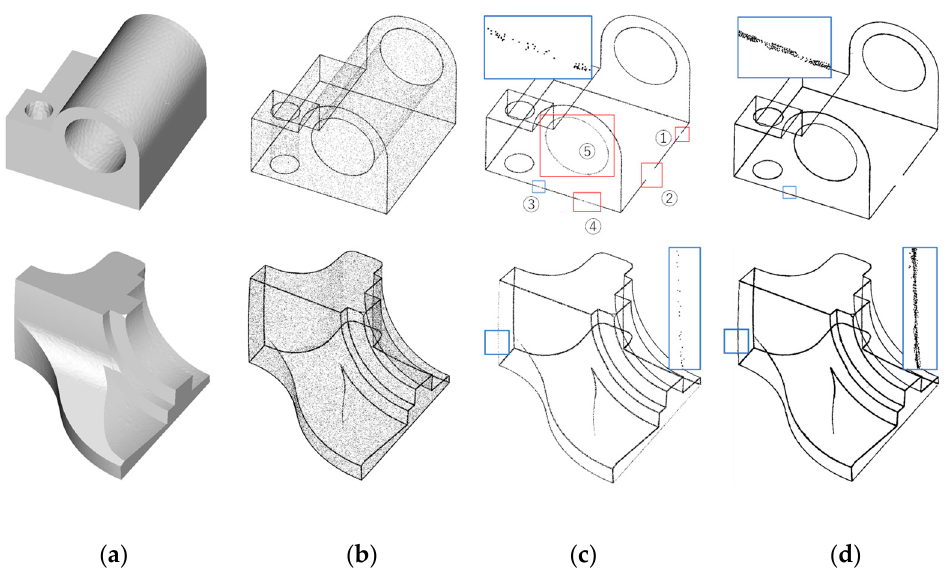
Figure 2. The upsampling results of the edge data for Joint (top) and Fandisk (bottom); ( a ) are the original polygon model, ( b ) are the original point cloud and extracted 3D edges, ( c ) are the modified edge data, and ( d ) are the upsampling results of the modified edge data.